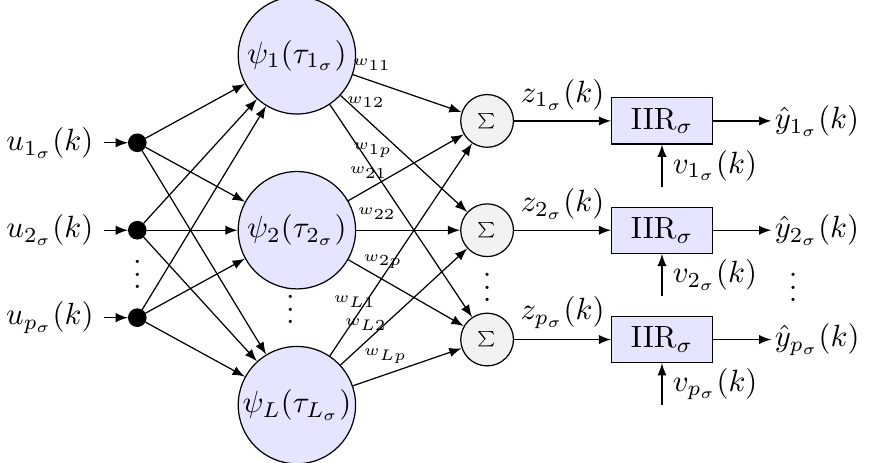
Figure 4. Diagram of a wavenet neural network with an IIR filter in cascade where σ can be left, l or l , r right, r , i.e., σ = { }